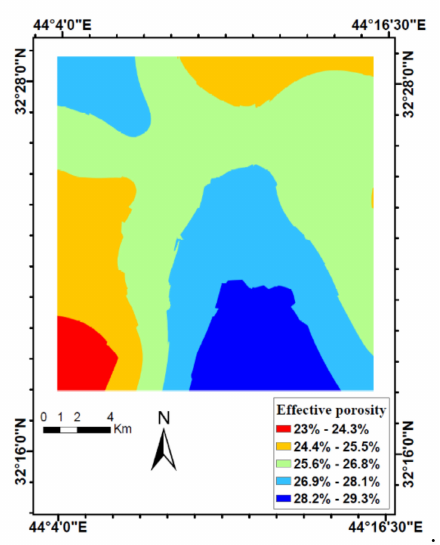
Figure 15. Actual e ff ective porosity map for Dibdibba aquifer (data obtained from the Iraqi Ministry of Water Resources and Al-Qadisiyah University, Iraq).